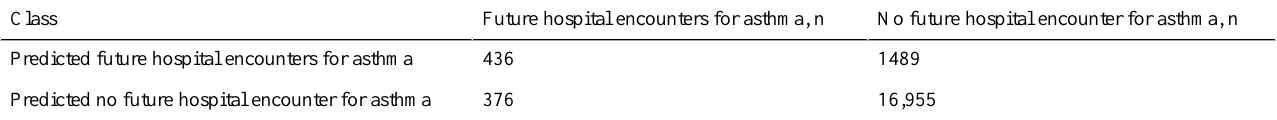
Table 5. Our final model’s confusion matrix when the cutoff threshold for conducting binary classification was set at the top 10.00% (1926/19,256) of asthmatic patients with the highest predicted